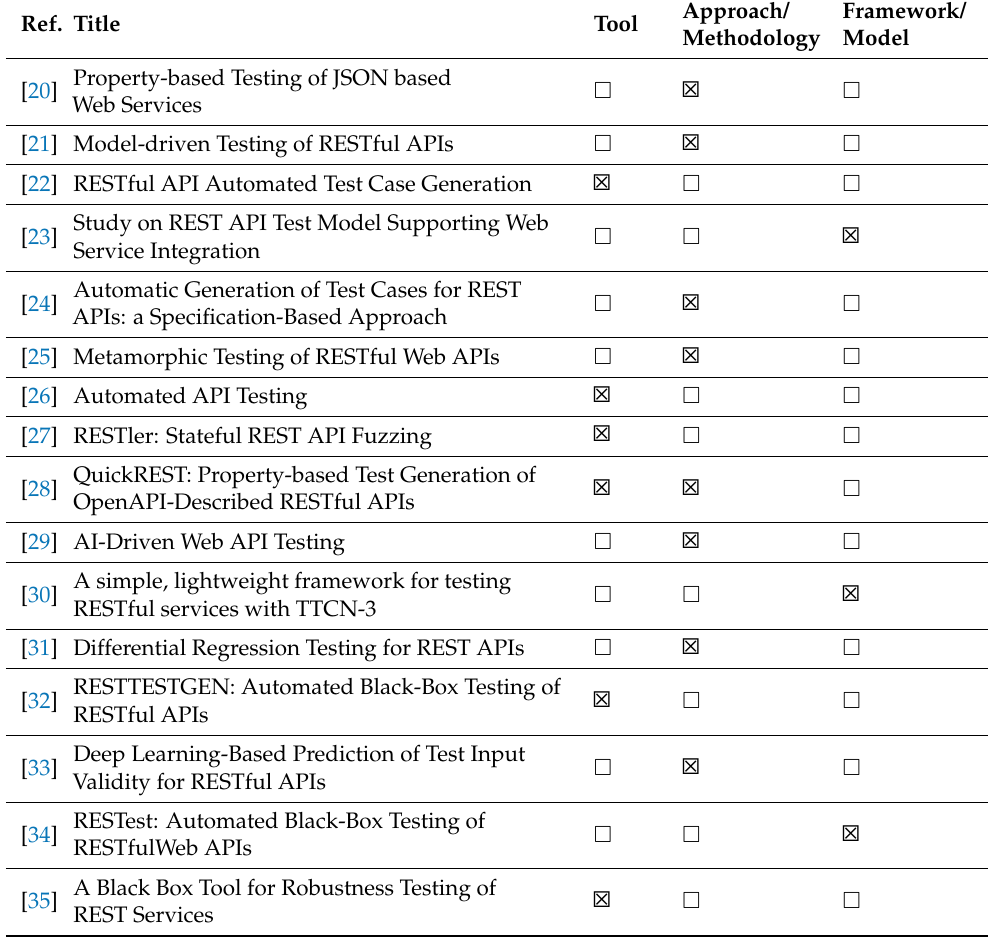
Approach/ Framework/ Methodology Model